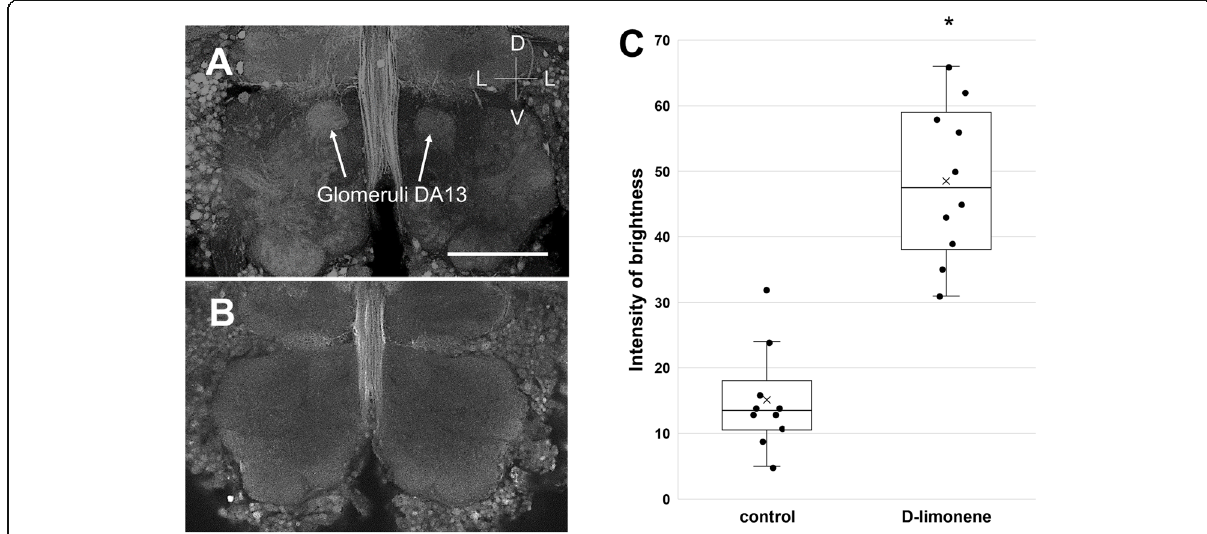
Fig. 6 AL glomeruli activated by D-limonene odor stimulation via maxillary palps. a A pair of glomeruli DA13 labeled by anti-pERK immunostaining. b Control image without odor stimulation. The bar indicates 100 μ m. c Boxplot comparing the brightness of activated glomeruli DA13 in the test ( n = 10) with the background brightness in the control ( n = 10). Boxplot whiskers are 1.5× interquartile range